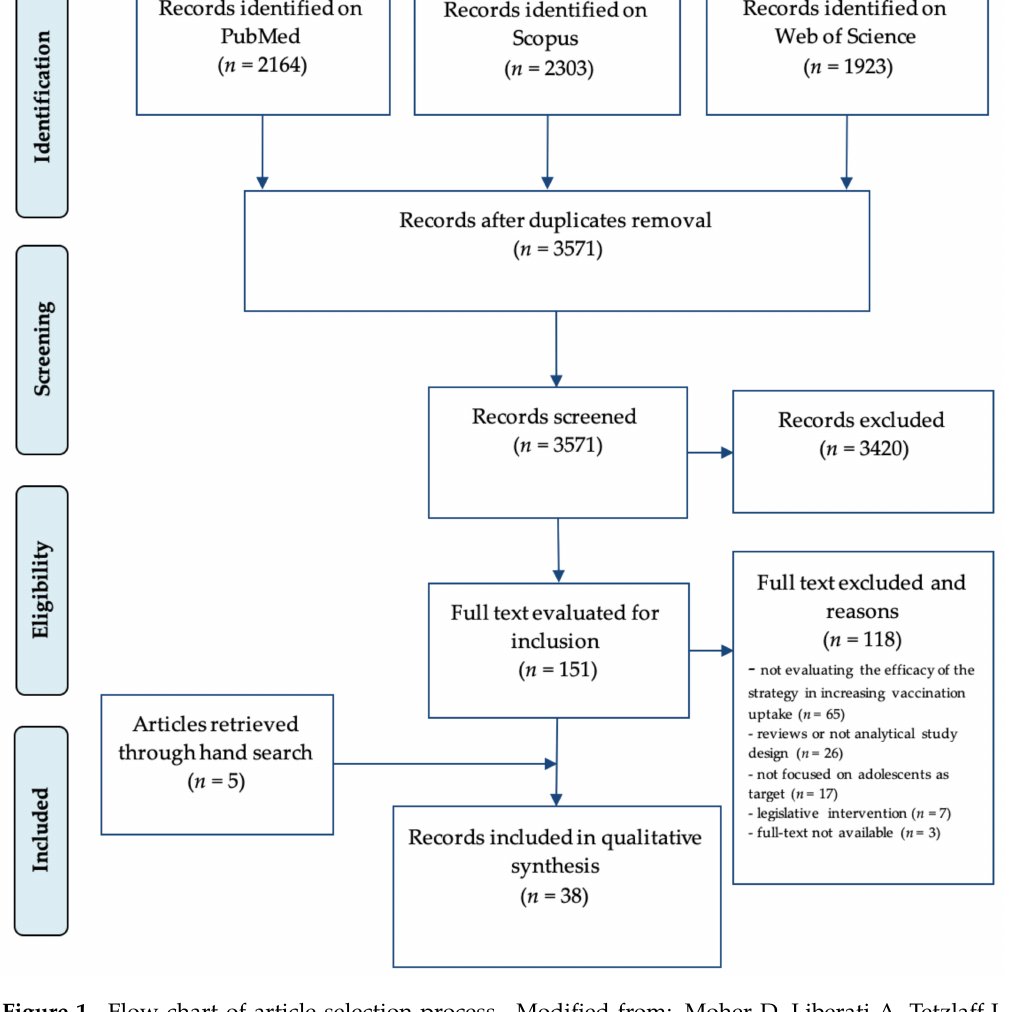
Figure 1. Flow chart of article selection process. Modified from: Moher D, Liberati A, Tetzla ff J, Altman DG, The PRISMA Group (2009). Preferred Reporting Items for Systematic Reviews and Meta-Analyses: The PRISMA Statement. BMJ 2009; 339:b2535, doi: 10.1136 / bmj.b2535